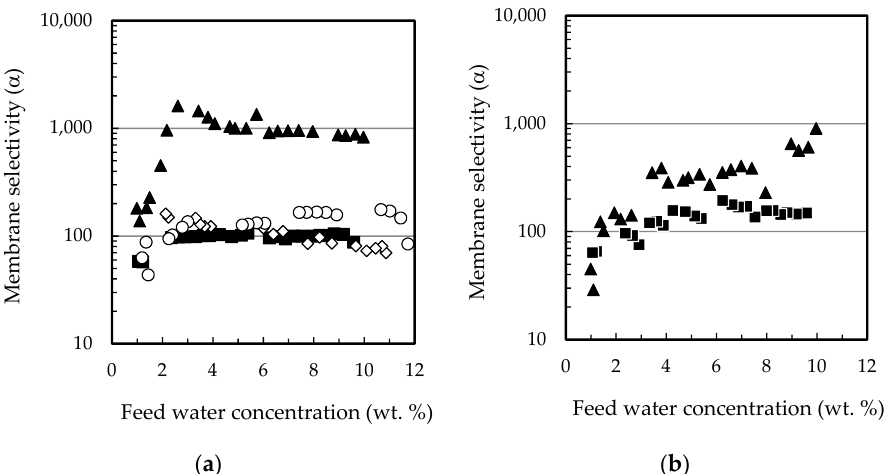
Figure 6. Selectivity as a function of feed water content for mixtures of different composition: ( a ) water/ethanol, ( b ) water/ethyl lactate. ( (cid:78) ) contains 13.5% lactic acid, 17.7% ethyl lactate, 10% water and 58.8% ethanol; ( (cid:4) ) 17.7% ethyl lactate, 10% water and 72.3% ethanol;